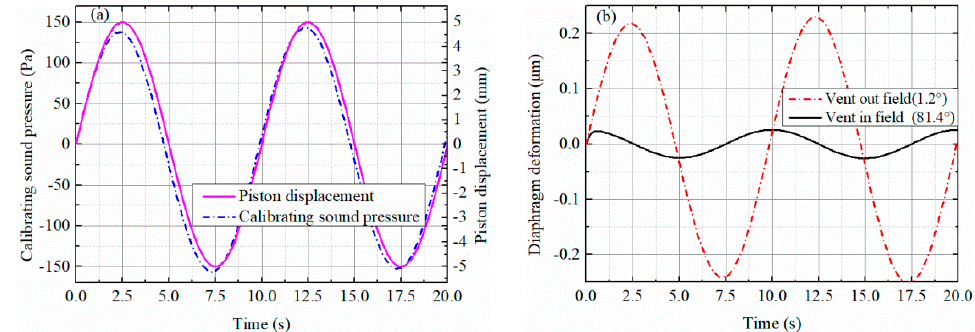
Figure 15. ( a ) Waveform of the piston displacement and the calibrating sound pressure at 0.1 Hz. ( b ) Waveform of the diaphragm deformation at 0.1 Hz in two venting states.